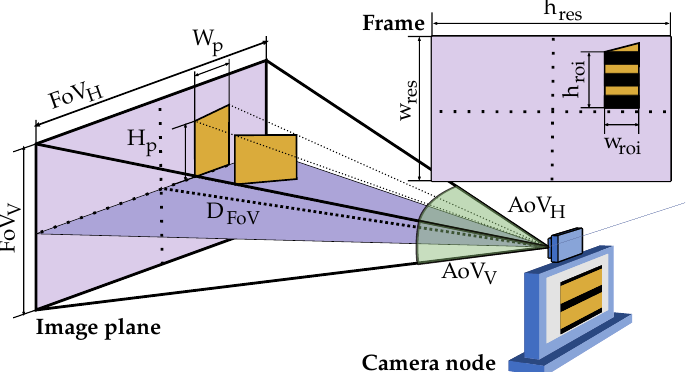
Figure 4. Geometrical parameters involved in the computation of the maximum achievable node’s data